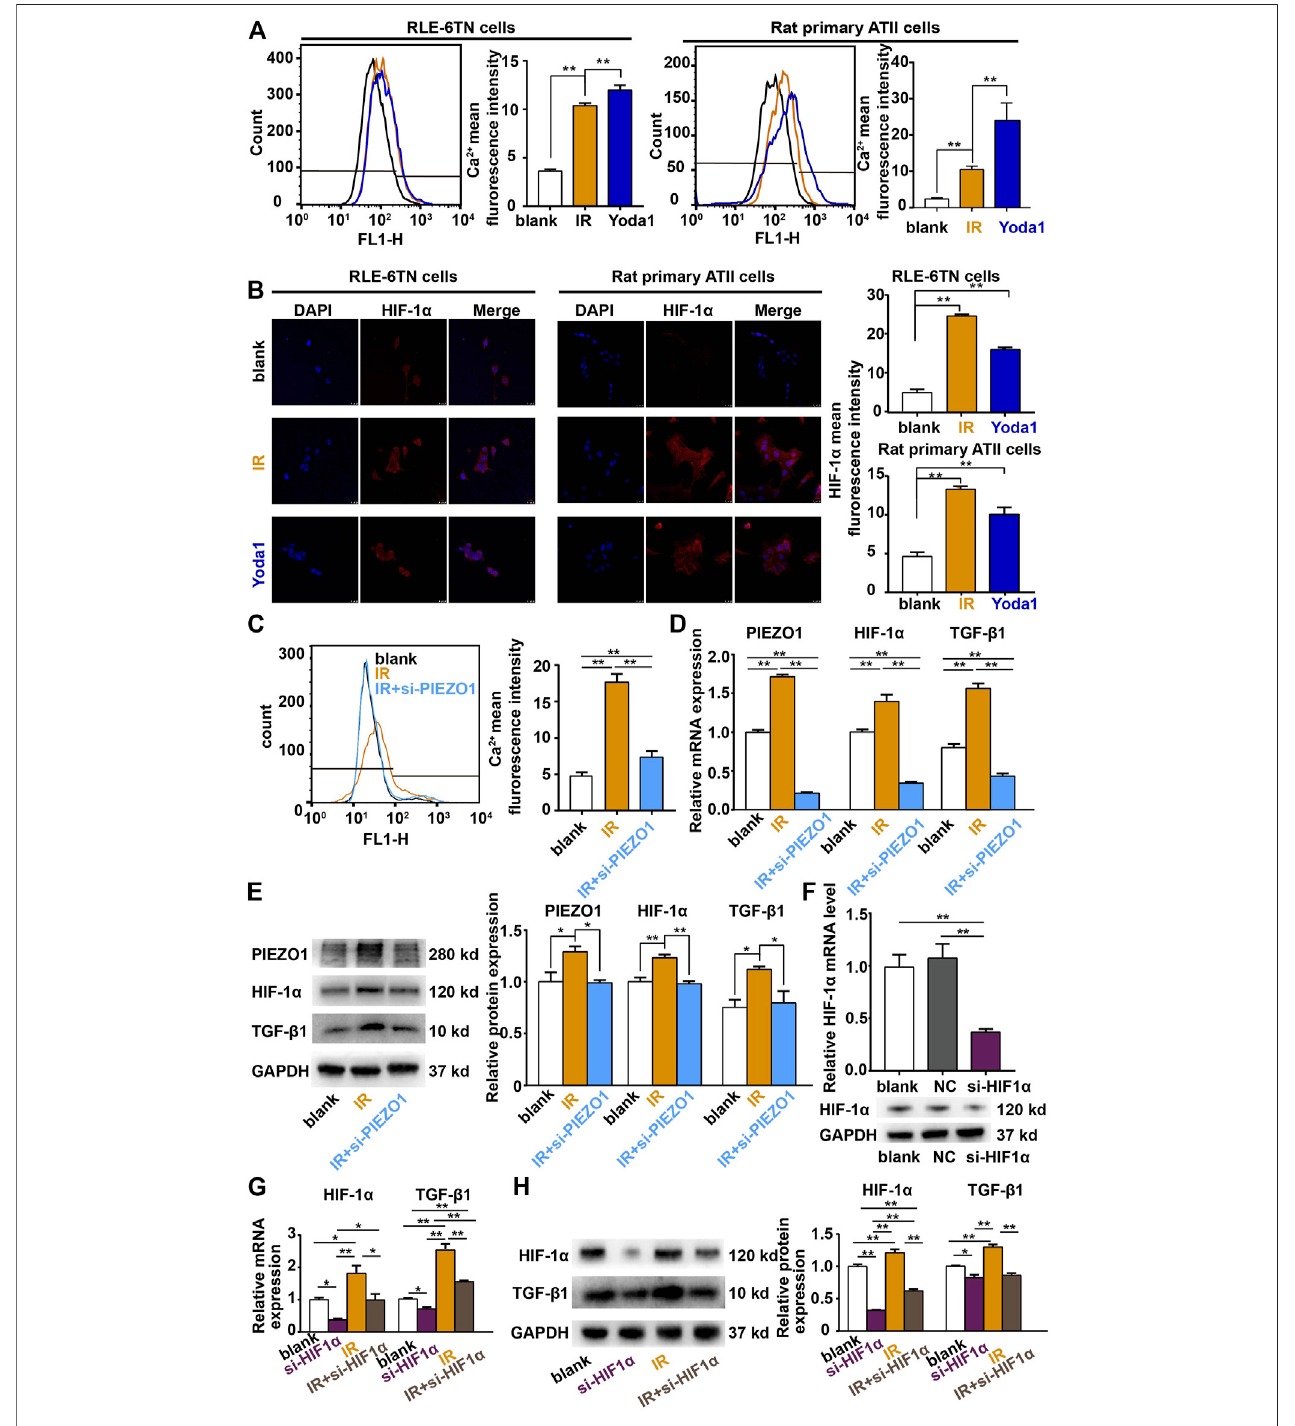
FIGURE 3 | PIEZO1 modulates epithelial-mesenchymal transition via Ca 2+ /HIF-1 α signaling. (A,B) Irradiation (IR) and the selective PIEZO1 activator Yoda1 increased calcium in fl ux in RLE-6TN cells and primary rat lung epithelial cells. (B) Immuno fl uorescence staining showed that HIF-1 α expression was upregulated by Yoda1andIR.NucleiwerestainedwithDAPI(blue). (C) FlowcytometrymeasurementofintracellularCa 2+ concentrationsfoundthatIR-inducedcalciumin fl uxwaspartly blocked by PIEZO1 knockdown. (D) qPCR results found that increased HIF-1 α and TGF- β 1 expression after IR was blocked by PIEZO1 knockdown. (E) Representative Western blotting images and histograms showing IR-induced PIEZO1, HIF-1 α and TGF- β 1 protein expression were blocked by PIEZO1 knockdown. Note: The Western blotting images have been subjected to cropping and stitching inresponse to the reviewers ’ comments. The original fi gures can be seen in the supplemental materials. (F) HIF-1 α mRNA and protein expression were successful inhibited by speci fi c siRNA to HIF-1 α (si-HIF-1 α ). (G,H) The enhanced expression of TGF- β 1mRNA (G) andprotein (H) afterIRwassigni fi cantlyreducedwhenHIF-1 α expressionwasinhibitedbysi-HIF-1 α .Dataarepresentedwiththemeans ± SEMs(n (cid:2) 3). *, p < 0.05; and **, p < 0.01.